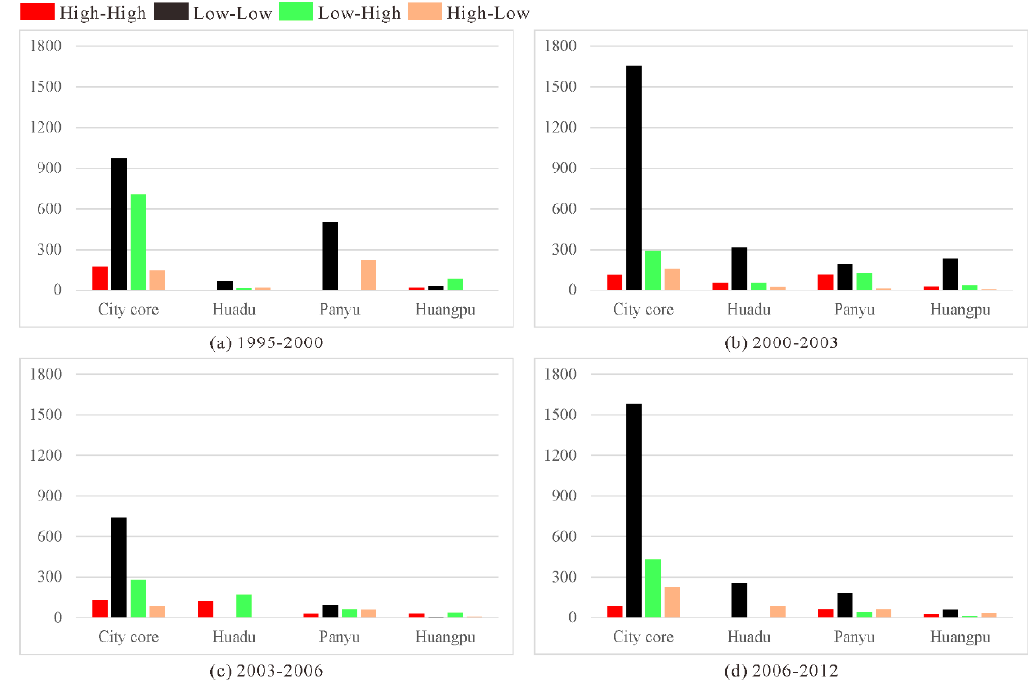
Figure 4. The respective numbers of parcels categorized as high-high, high-low, low-low and low-high in the city core, Huadu, Panyu and Huangpu (threshold distance = 2 km) for the periods of ( a ) 1995–2000, ( b ) 2000–2003, ( c ) 2003–006 and ( d ) 2006–2012. The city core includes districts of Baiyun, Haizhu, Liwan, Tianhe and